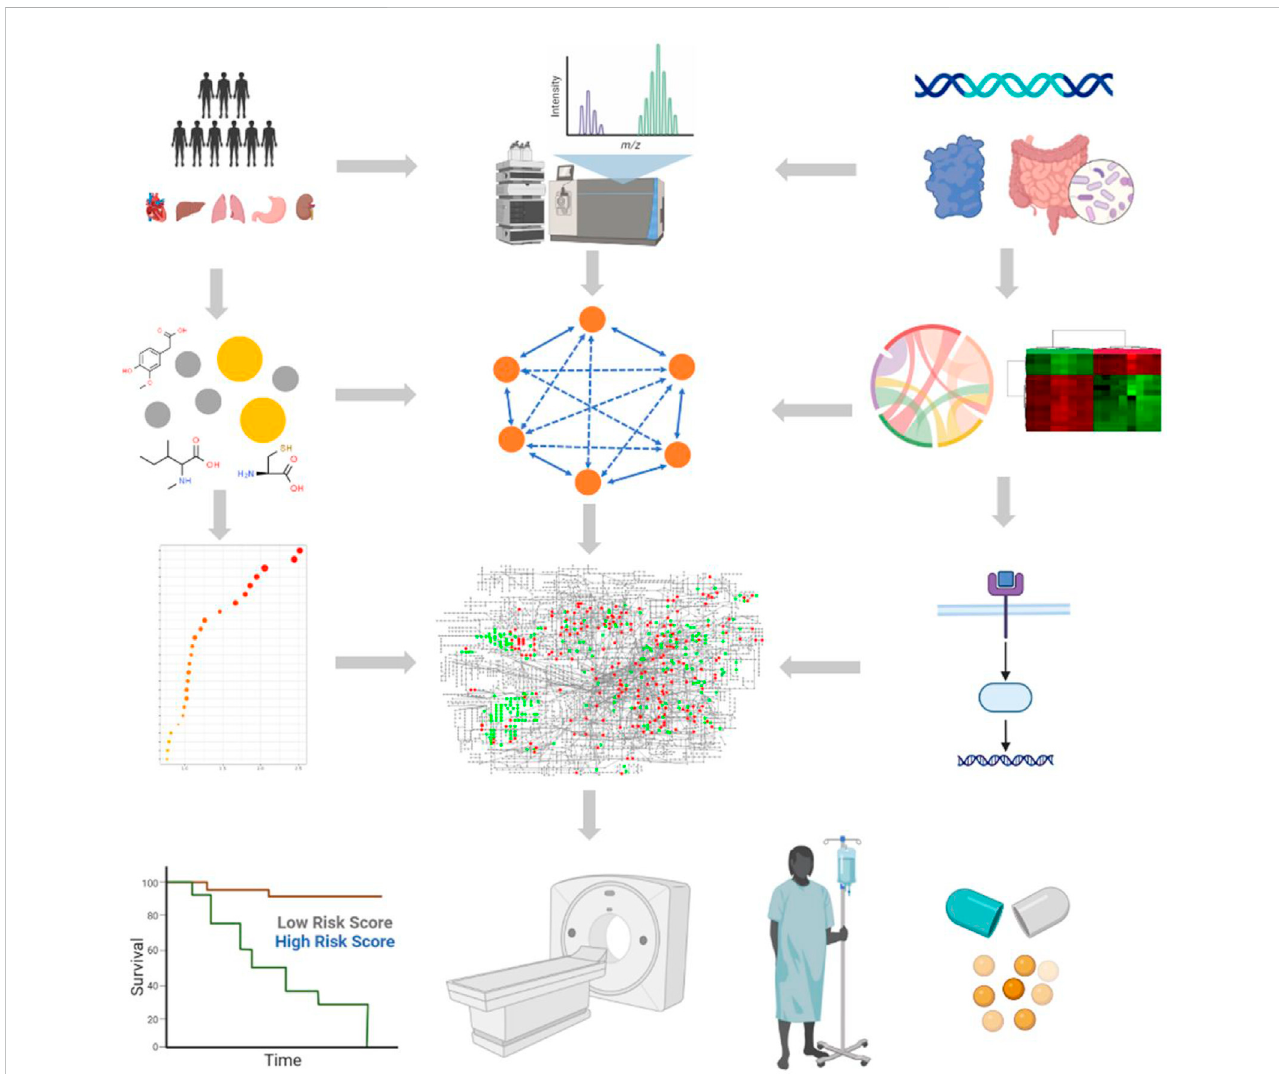
FIGURE 1 Brief work fl ow of small-molecule metabolite-based functional metabolomics. The fi rst stage involves experimental design, followed by the election of biological subjects, sample collection, preparation, and metabolite extraction. Metabolites are detected using speci fi c detection techniques; data pre- processingisusedtopre-processrawsignalstoproducedatainasuitableformatforsubsequentstatisticalanalysis;then,datanormalizationisusedtoreduce the system and technical bias; next, small-molecule metabolites are fi ltered and quanti fi ed for signi fi cant biomarkers of interest; statistical analyses and univariate and multivariate statistical analyses are used to identify signi fi cantly expressed metabolites; and fi nally, data are interpreted through biomarker discoveryandfunctionalinterpretation.Multi-omics(genome,transcriptome,proteome,metabolome,andmicrobiome)dataarecollectedfrompatientsand integratedtoidentifypersonalizedfunctionalsignaturesusingcomplexandcomprehensivenetworkanalysis.Next,thesigni fi cantlyexpressedmetabolitesare subsequently linked to the biological context by enrichment and pathway analysis. Applications of small-molecule candidate metabolites for biomarker discovery, disease diagnosis, prognosis, and treatments in clinical studies. Figure was drawn using BioRender and